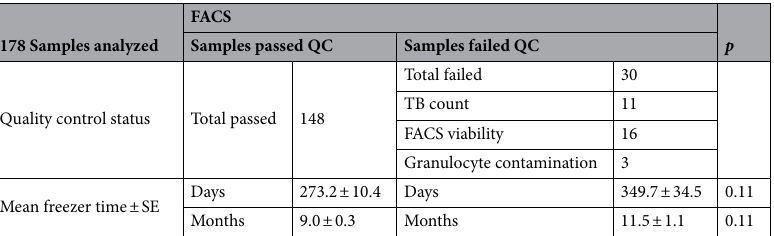
Table 2. Quality control overview of cryopreserved